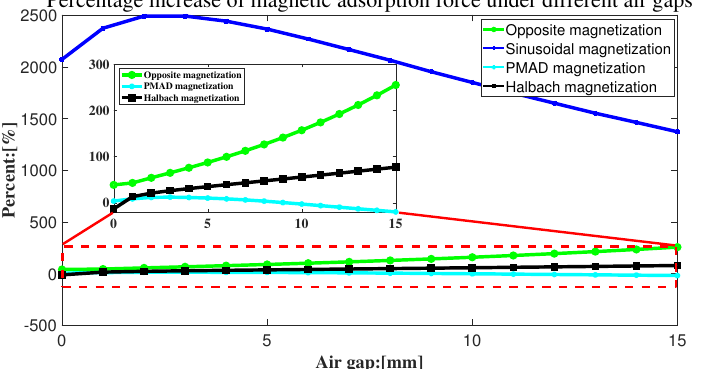
Figure 16. Comparison of the percent improvement with the magnetization method proposed in this paper and other